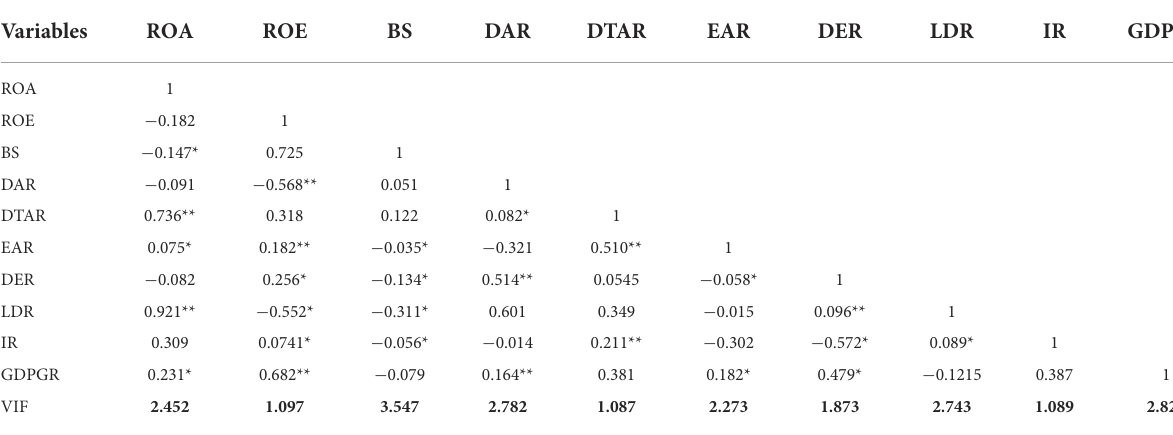
TABLE 5 Pearson correlation matrix and VIF.